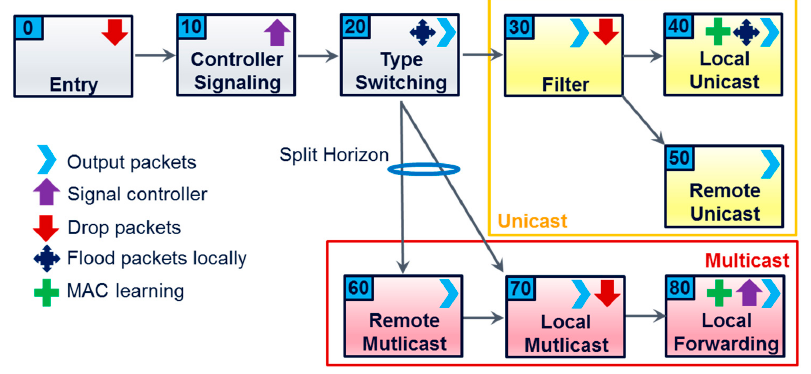
Figure 9. Flow tables for the OVS.